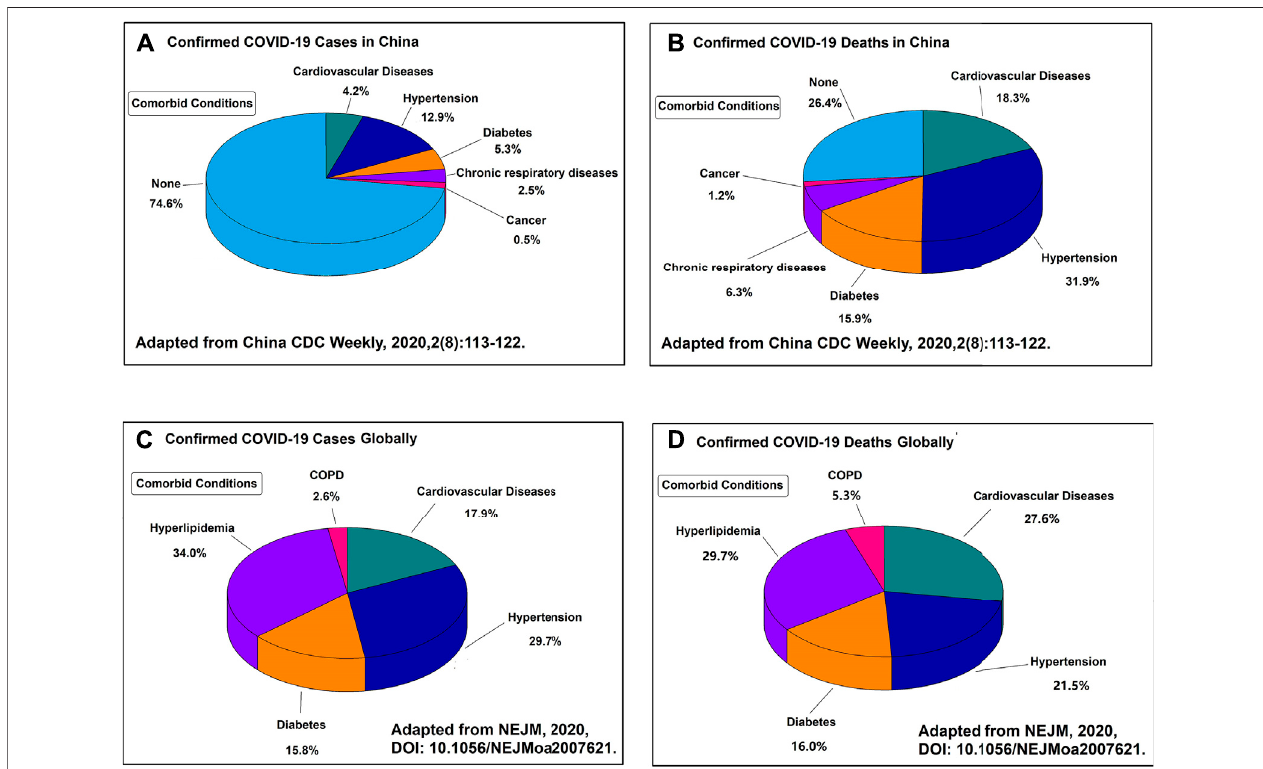
FIGURE 1 | (A) Proportion of the Chinese patients and their comorbid conditions that were diagnosed with COVID-19. (B) Proportion of the Chinese patients and their comorbid conditions that died from COVID-19. (C) Proportion of the global patients and their comorbid conditions that were diagnosed with COVID-19. (D) Proportion of the global patients and their comorbid conditions that died from COVID-19. All the four fi gures indicate that the major complications of COVID-19 are the cardiovascular related diseases.